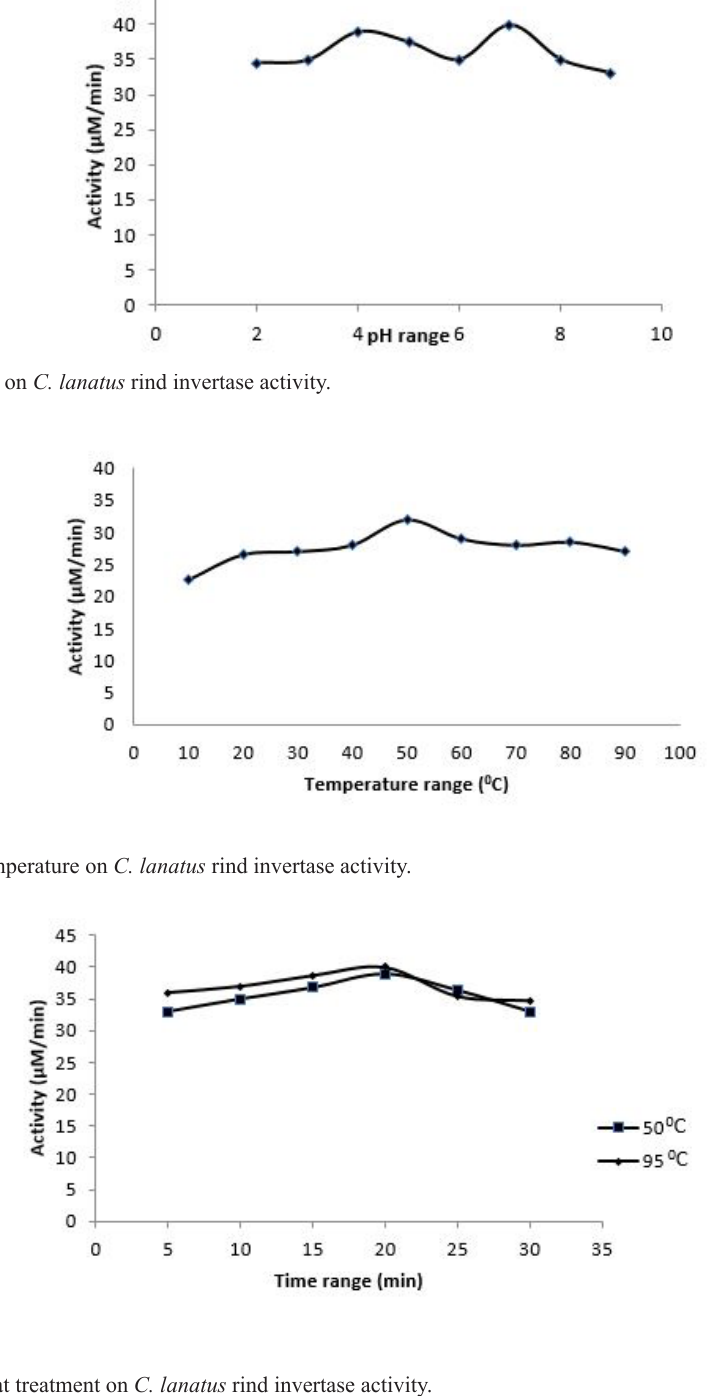
activity observed at less than 10 ºC (temperature at which all reactions were carried out) while the activity was 32.5% higher after incubation for 20 min at 95